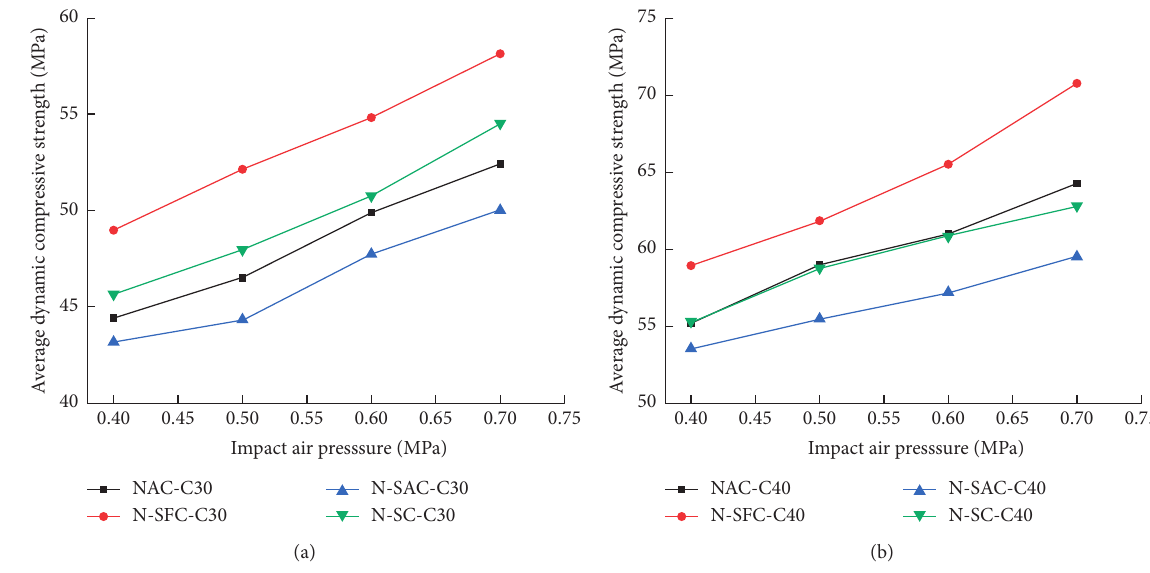
Figure 13: Coal gangue concrete destruction characteristics under different gas pressures. (a) C30 groups. (b) C40